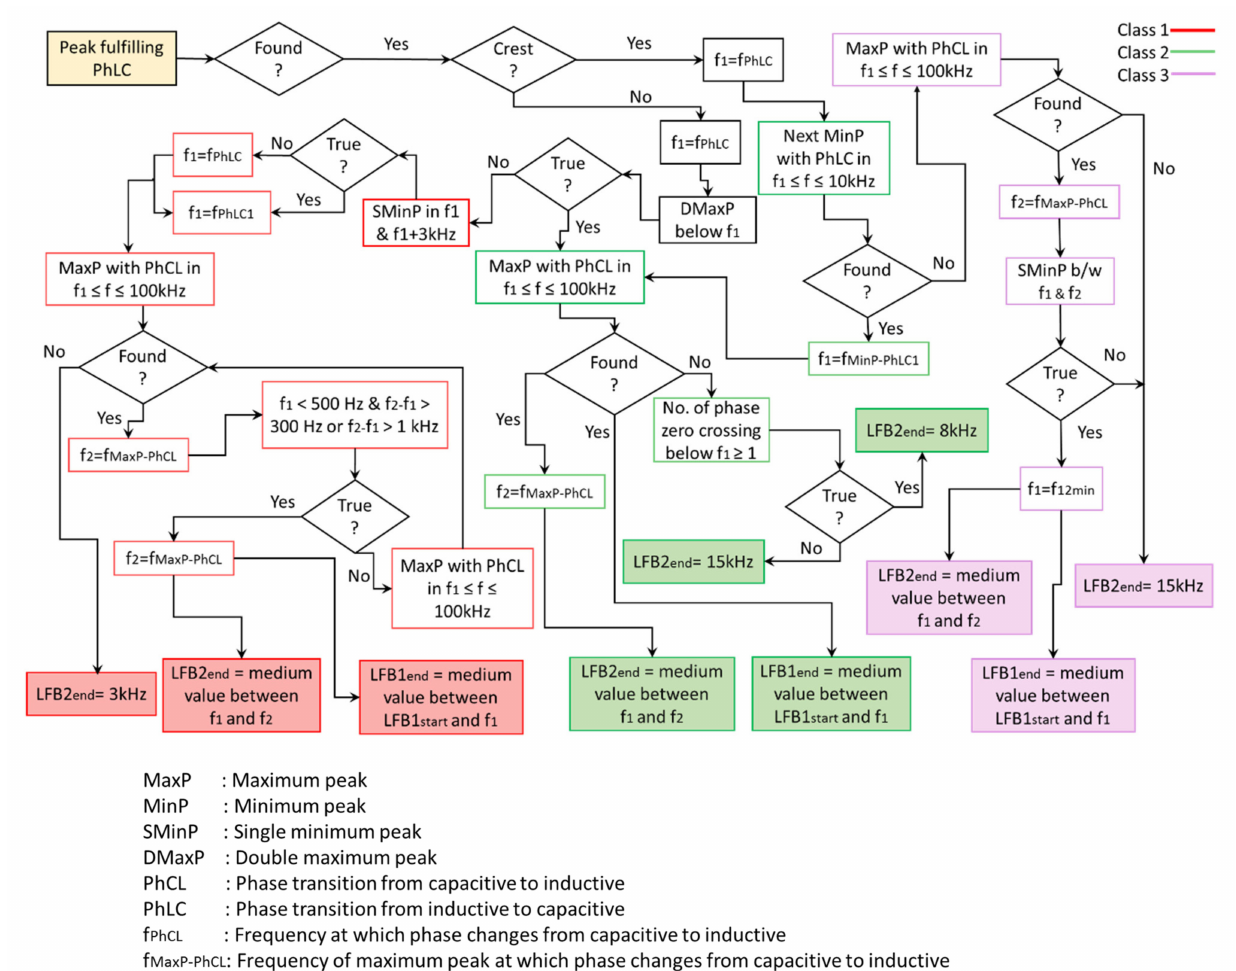
Figure 6. Workflow of the algorithms for identification of the low-frequency